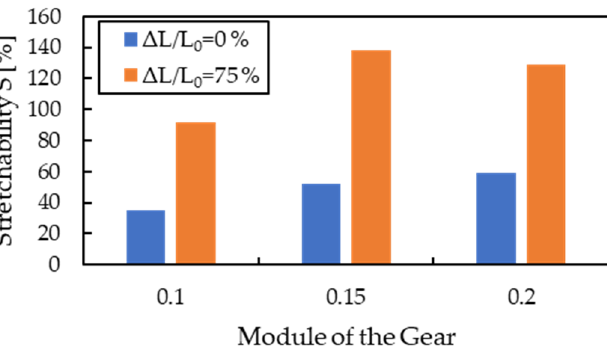
Figure 7. Stretchability evaluation of interconnect fabricated using the proposed method.